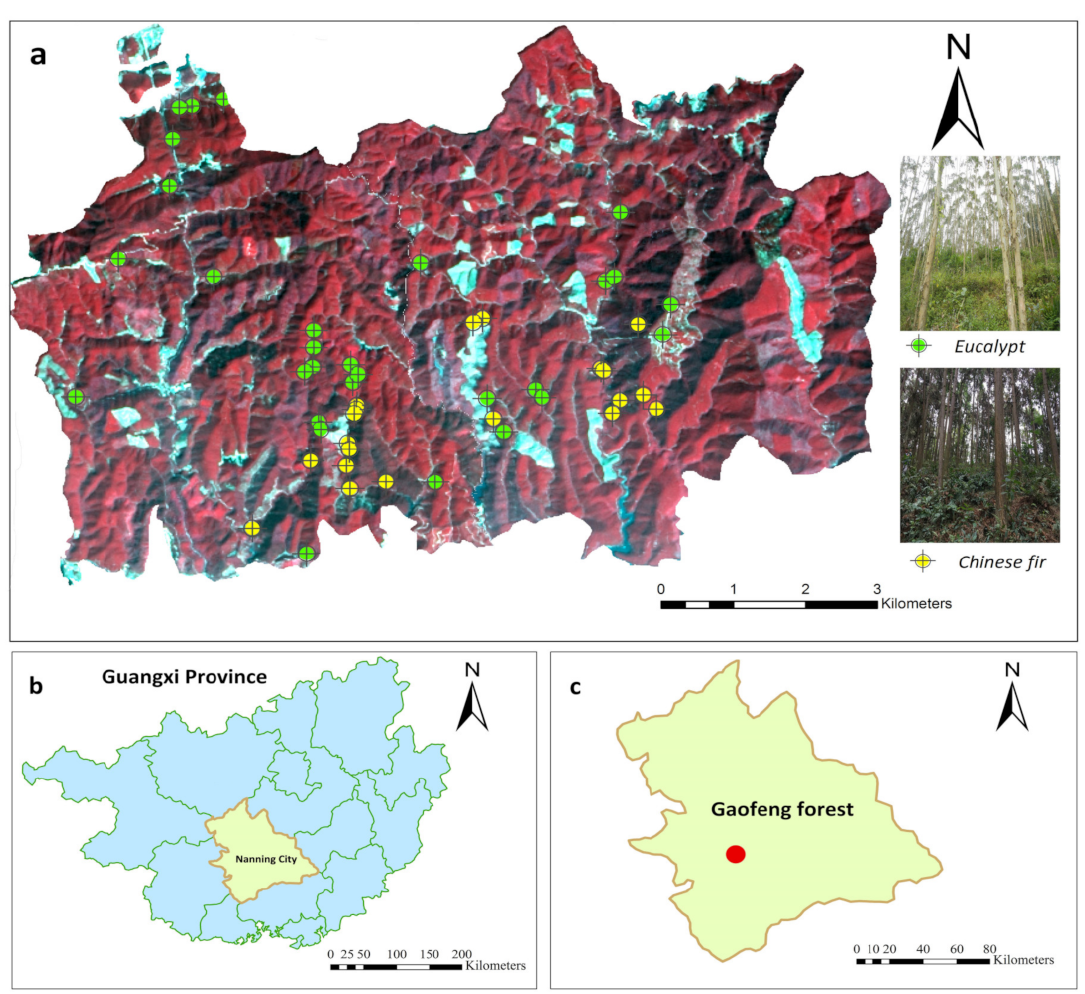
Figure 1. The location of the study site in Gaofeng Forest and sample plots distribution of two main tree species (Chinese fir and Eucalypt). ( a ) The Landsat 8 satellite image (June 2017) of study site; ( b ) the location of Nanning city; ( c ) the location of the Gaofeng